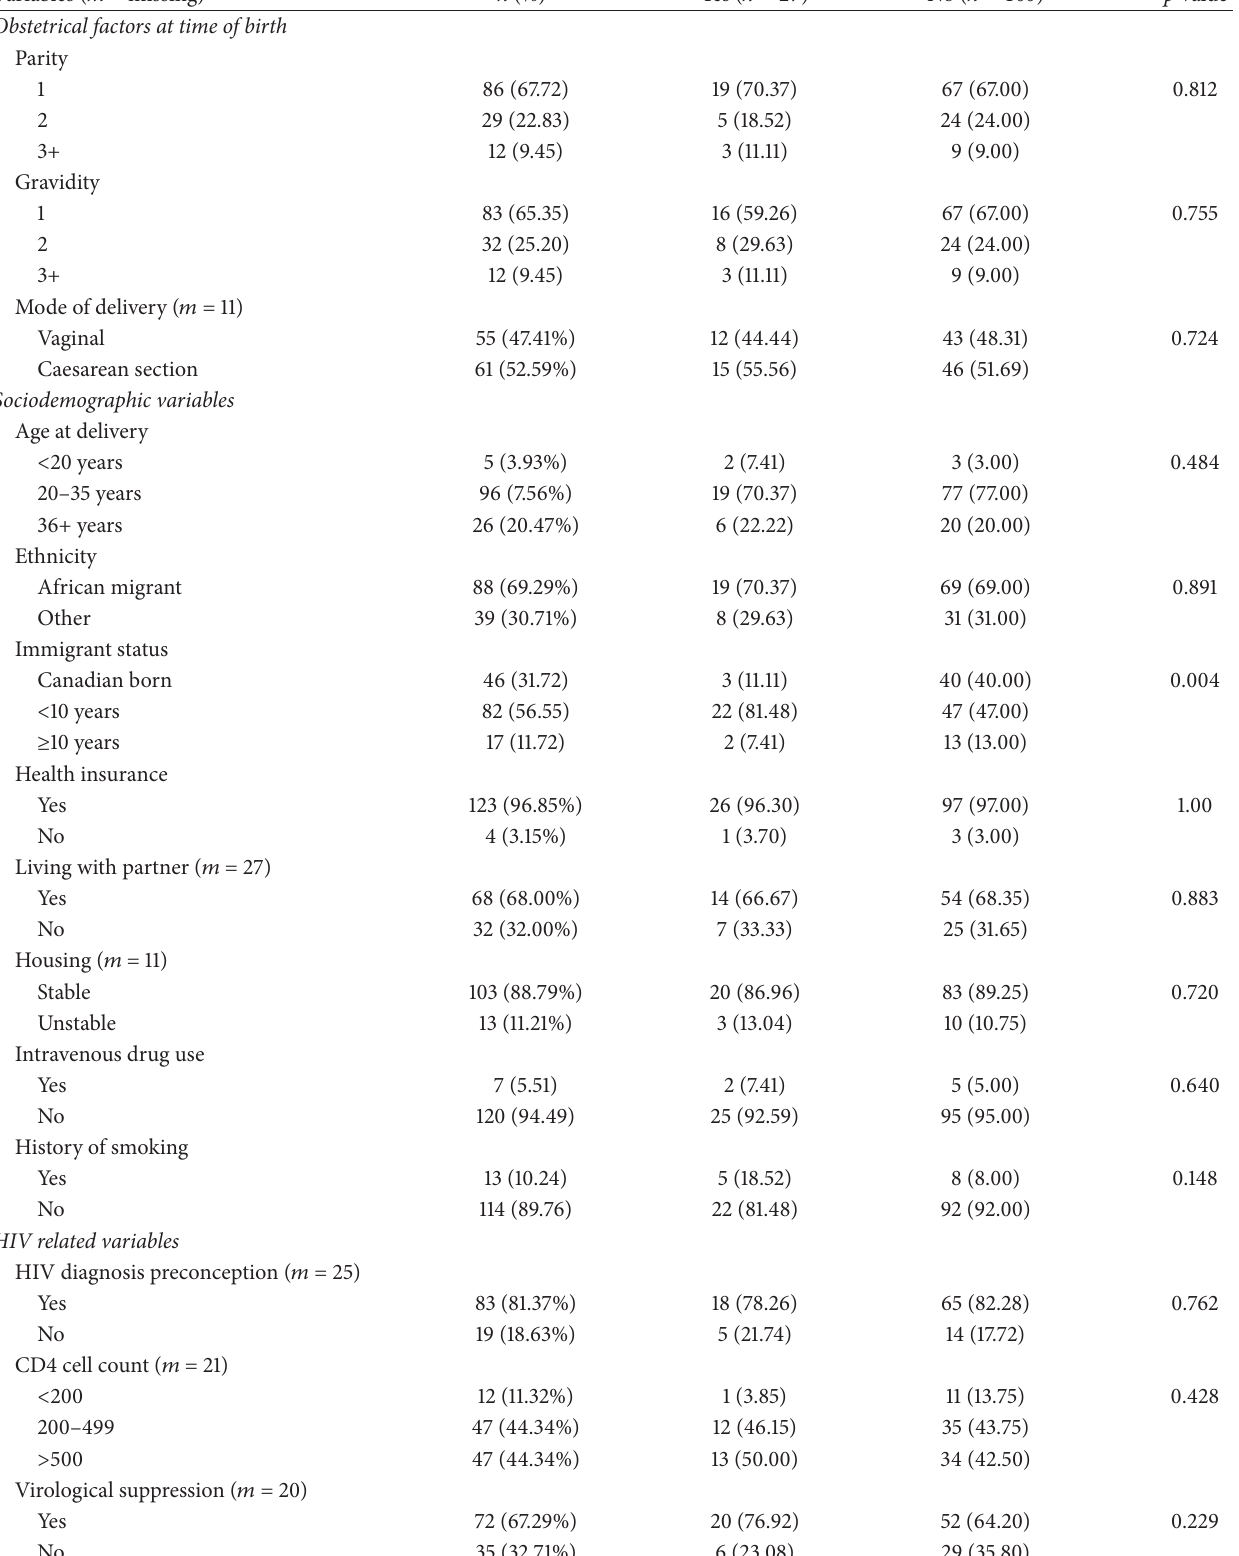
Table 2: Descriptive statistics associated with adverse obstetrical outcomes among women living with HIV ( 𝑛 = 127 deliveries) Variables ( 𝑚 = missing)